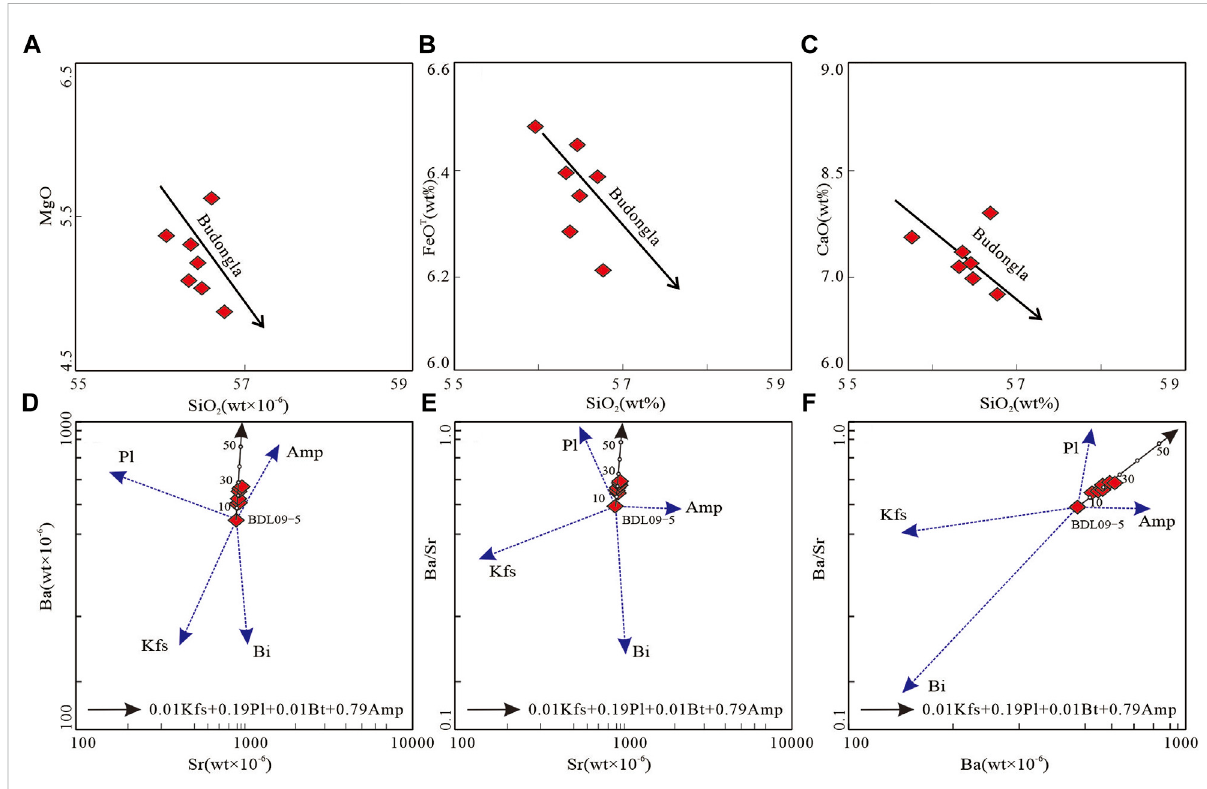
FIGURE 7 Huck diagram. (A-C) Element scatter diagrams; and (D-F) Quantitative simulation diagrams of crystallization